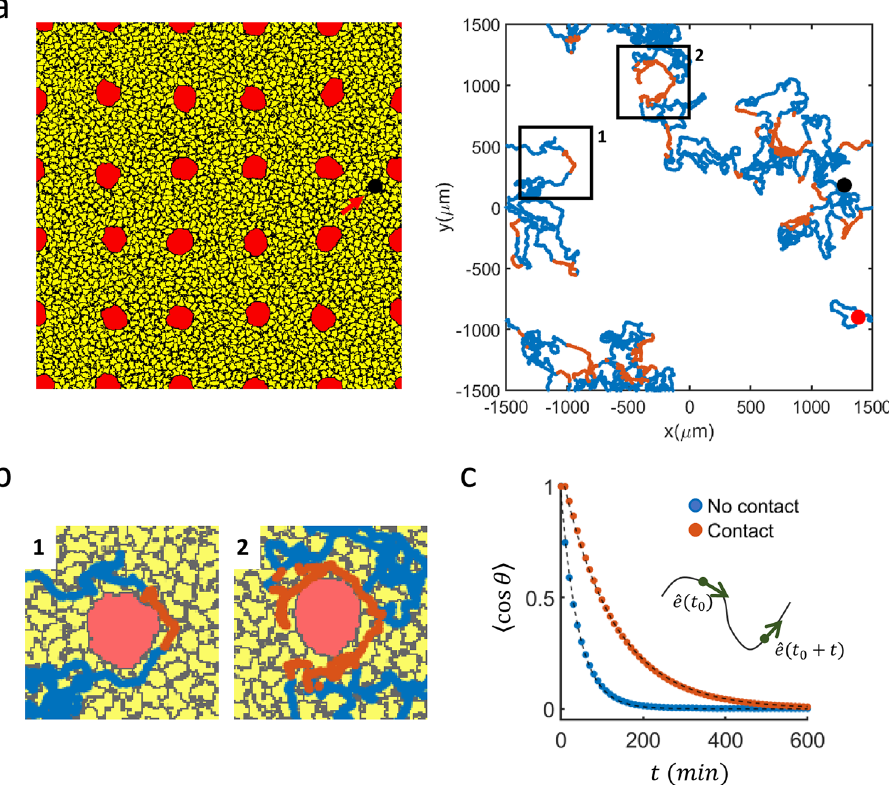
Figure 5. Influence of senescent cells on the moving trajectories of normal cells in confluency. ( a ) A snapshot image of a CPM simulation: (non-active) senescent cells (red) and (active) normal cells (yellow). One normal cell (randomly selected; marked by block dot) is traced in the right-hand side (red line: during a contact with a senescent cell; blue: during no contact with senescent cells). ( b ) Two blown-up insets of ( a ). Senescent cells move only a little passively. ( c ) Average dot product of two directional vectors separated by time t (see the 43.42 min) and τ 123.50 min) are a decay time constant of the schematic illustration). τ no _ contact ( contact ( = = corresponding exponential fit. The image in ( a ) was generated by Morpheus 2.2 (https:// morph eus. gitlab.